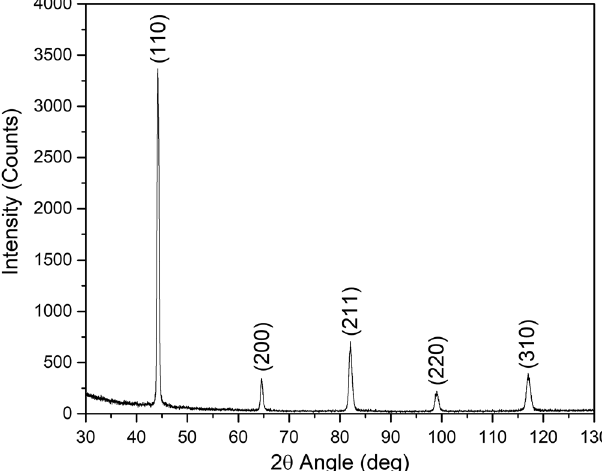
FIG. 11. GI-XRD measurement of a niobium thin film sample after the copper substrate had first been etched away. The sample was originally deposited at a substrate temperature of 700 °C with − 80 V substrate